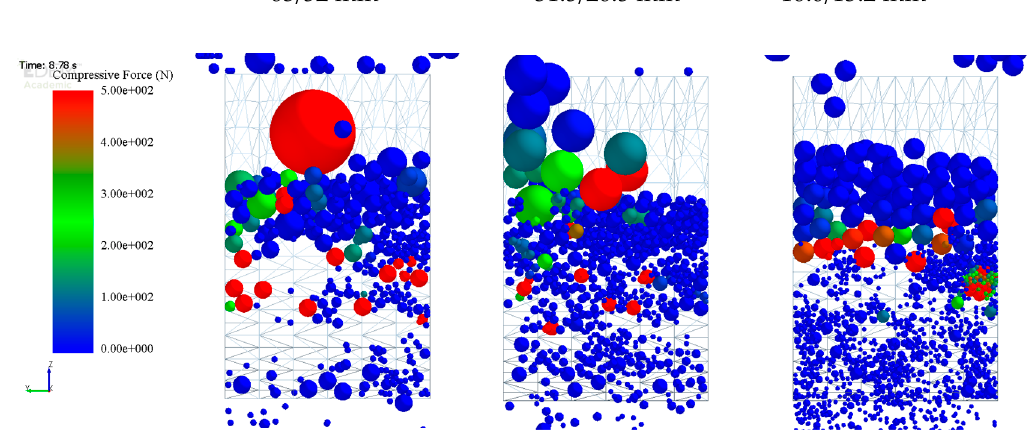
Figure 10. Particle bed compression inside the crushing chamber for different particle size classes fed to the crusher.